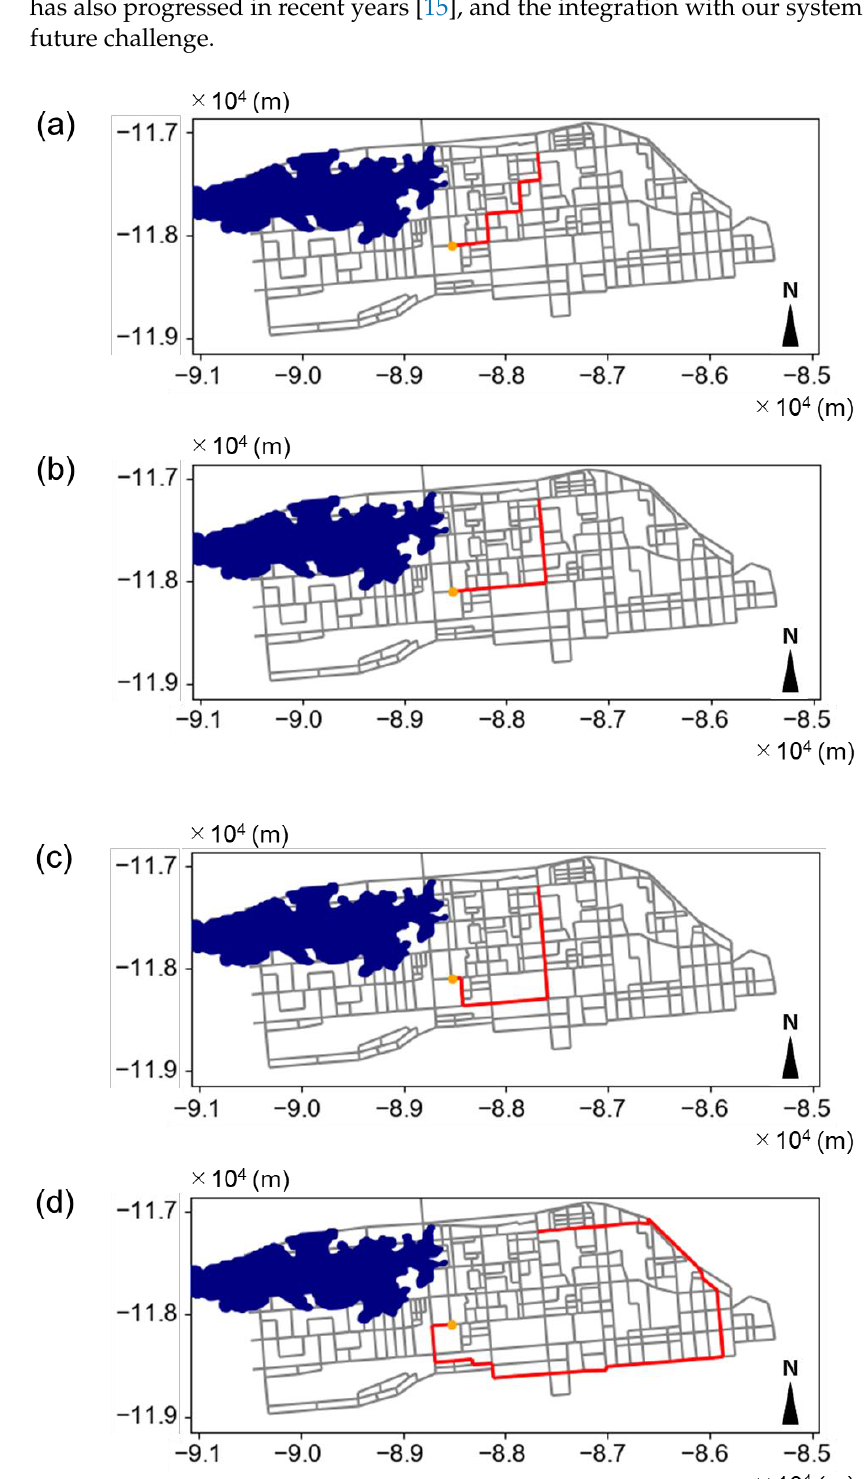
Figure 9. Evacuation route changes by model. ( a ) Model I; ( b ) C d = 1 in Model II; ( c ) C d = 5 in Model II; ( d ) C d = 10 in Model II